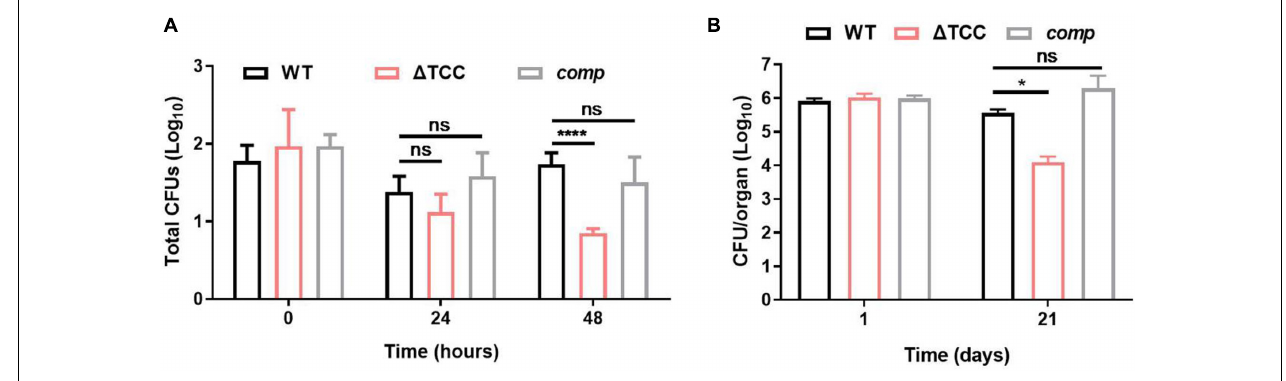
FIGURE 5 | Evaluation intracellular fitness of (cid:49) TCC mutant strain in vivo and in vitro . (A) RAW264.7 cells were seeded at 3 × 10 5 cells per well in 24-well culture plates. After adhesion, cells were infected with bacteria at MOI of 10. The extracellular bacteria were removed 2 h post infection by washing with PBS. The cells of M. bovis BCG were further incubated for 24 and 48h at 37 ◦ C. Then serially diluted (10-fold) cells lysates were spotted on a 7H10-OADC agar and cultured in 37 ◦ C. CFUs were counted after incubation for the indicated time ( n = 3 biological replicates per group, data are shown as the mean ± SEM, two-way ANOVA with Tukey’s multiple comparison test, compared with WT group; ns, not significant, **** p < 0.0001). (B) Mice were infected i.p. (1 × 10 7 ) with WT, (cid:49) TCC, or comp strains of M. bovis BCG. The number of surviving bacilli by CFU counting at the indicated time ( n = 4 biological replicates per group, data are shown as the mean ± SEM, two-way ANOVA with Tukey’s multiple comparison test, compared with WT group; ns, not significant, * p <